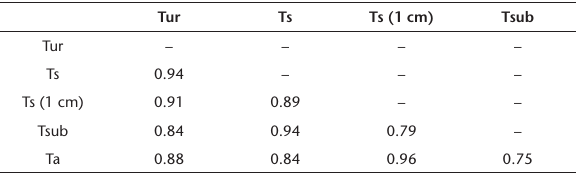
Table 4. Pairwise Pearson’s correlation values (r) for the envi- ronmental temperatures at São Jerônimo between March 2011 and October 2012. Tur, temperature under a rock; Ts, substrate temperature; Ts (1 cm), substrate temperature 1 cm above the ground; Tsub, substrate temperature 5 cm below the ground.